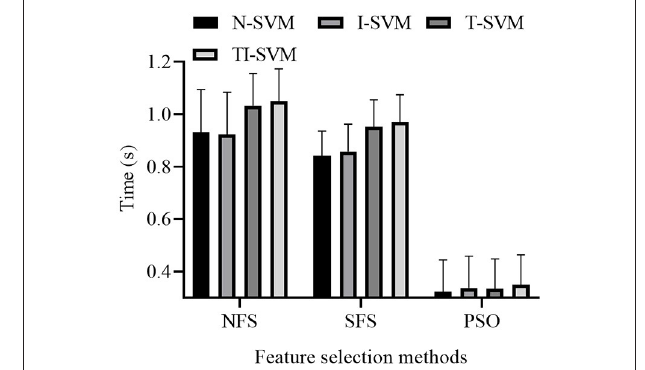
FIGURE 5 | Average training time of different EMG pattern recognition schemes of 12 subjects.